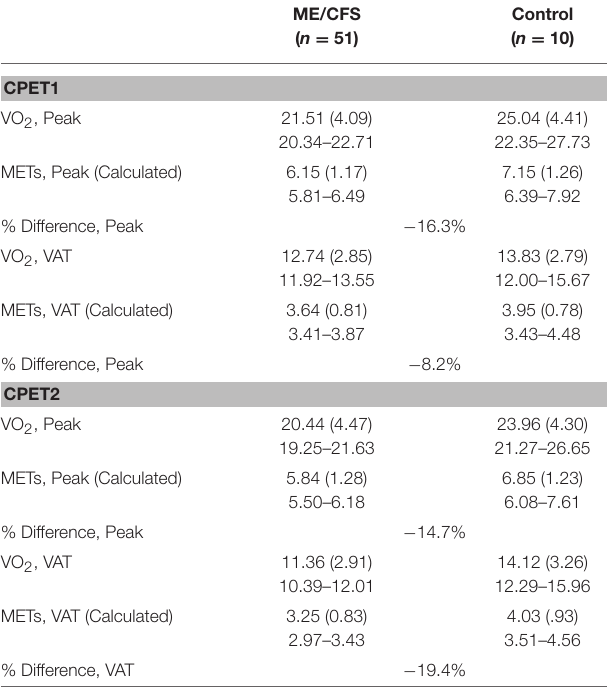
TABLE 5 | Raw and percent differences in metabolic equivalents between individuals with myalgic encephalomyelitis/chronic fatigue syndrome (ME/CFS) and matched sedentary individuals during serial cardiopulmonary exercise testing (CPET), based on re-analysis of data from Snell et al.